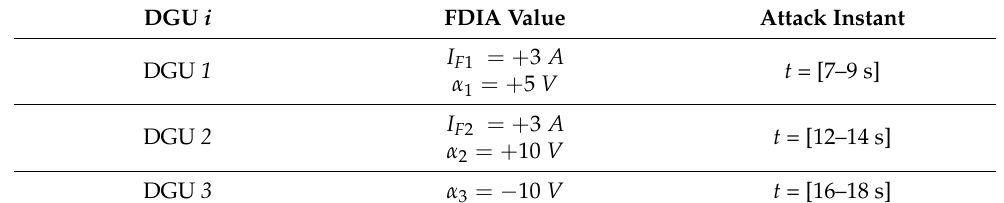
Table 8. Mixed current and voltage FDIA parameters.